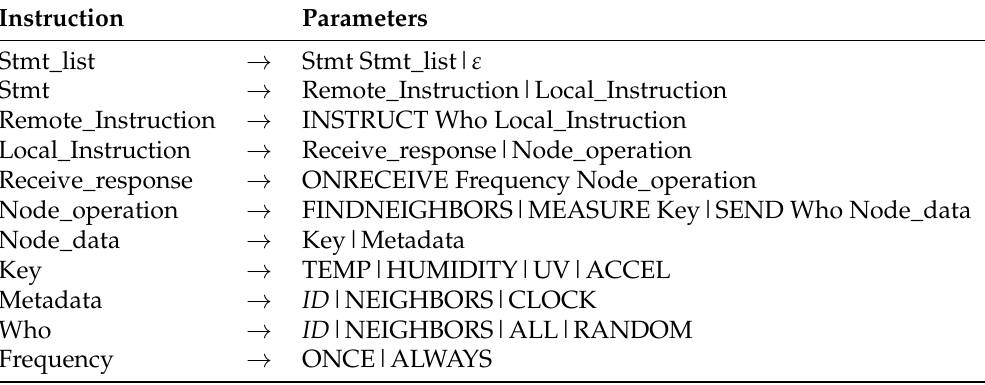
Table 5. The LL(1) grammar of the language designed for the developed architecture. Terminal symbols are capitalized, while ID refers to an unsigned 1-byte integer indicating a node’s assigned